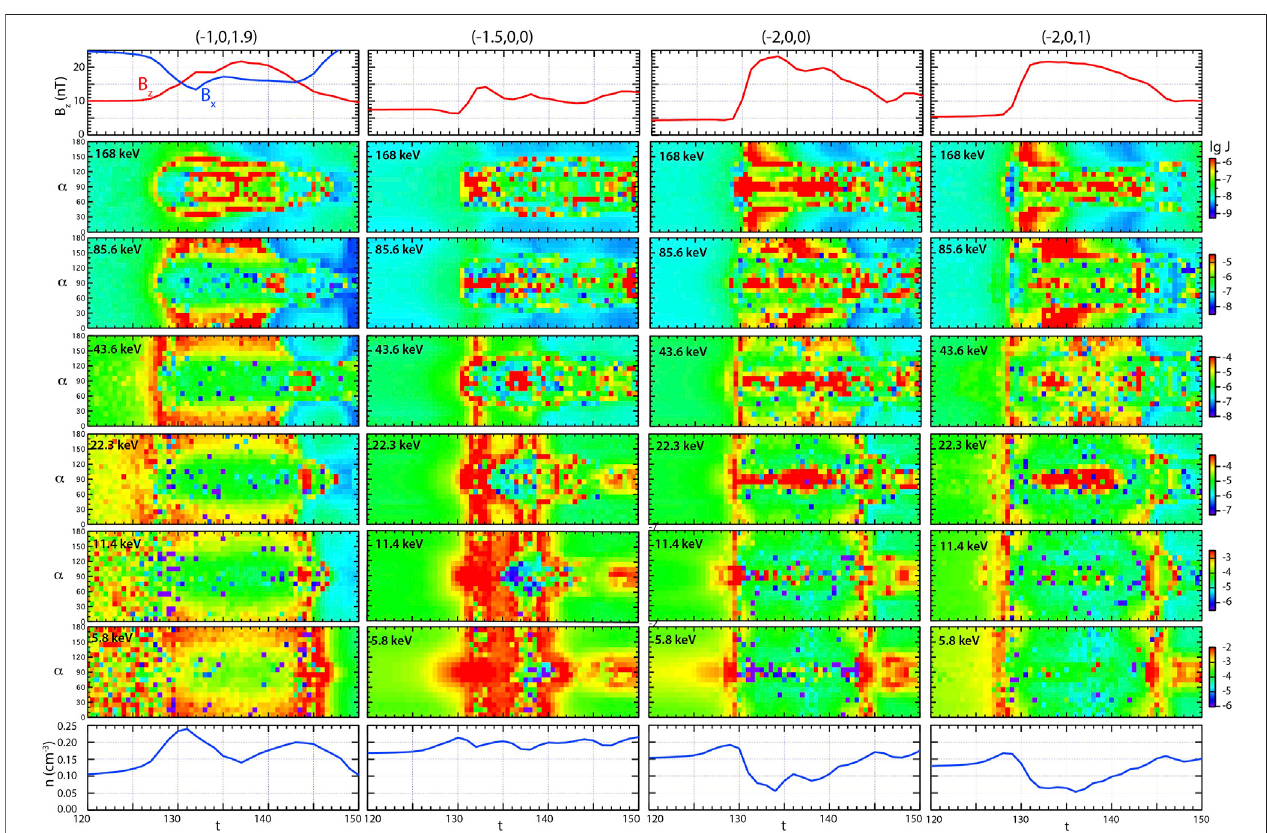
FIGURE3| Simulated electron fl uxesasfunctions oftime and pitchangle at four selected locations indicatedon top. Differentenergiesareindicated inthecolored panels.Thetopandbottompanelsshowthemagnetic fi eld B z (inred)andtheplasmadensity n ,respectively,atthethreelocations.ForthePSBLlocation,(-1,0,1.9),the magnetic fi eld component B x is also added (blue curve, top left